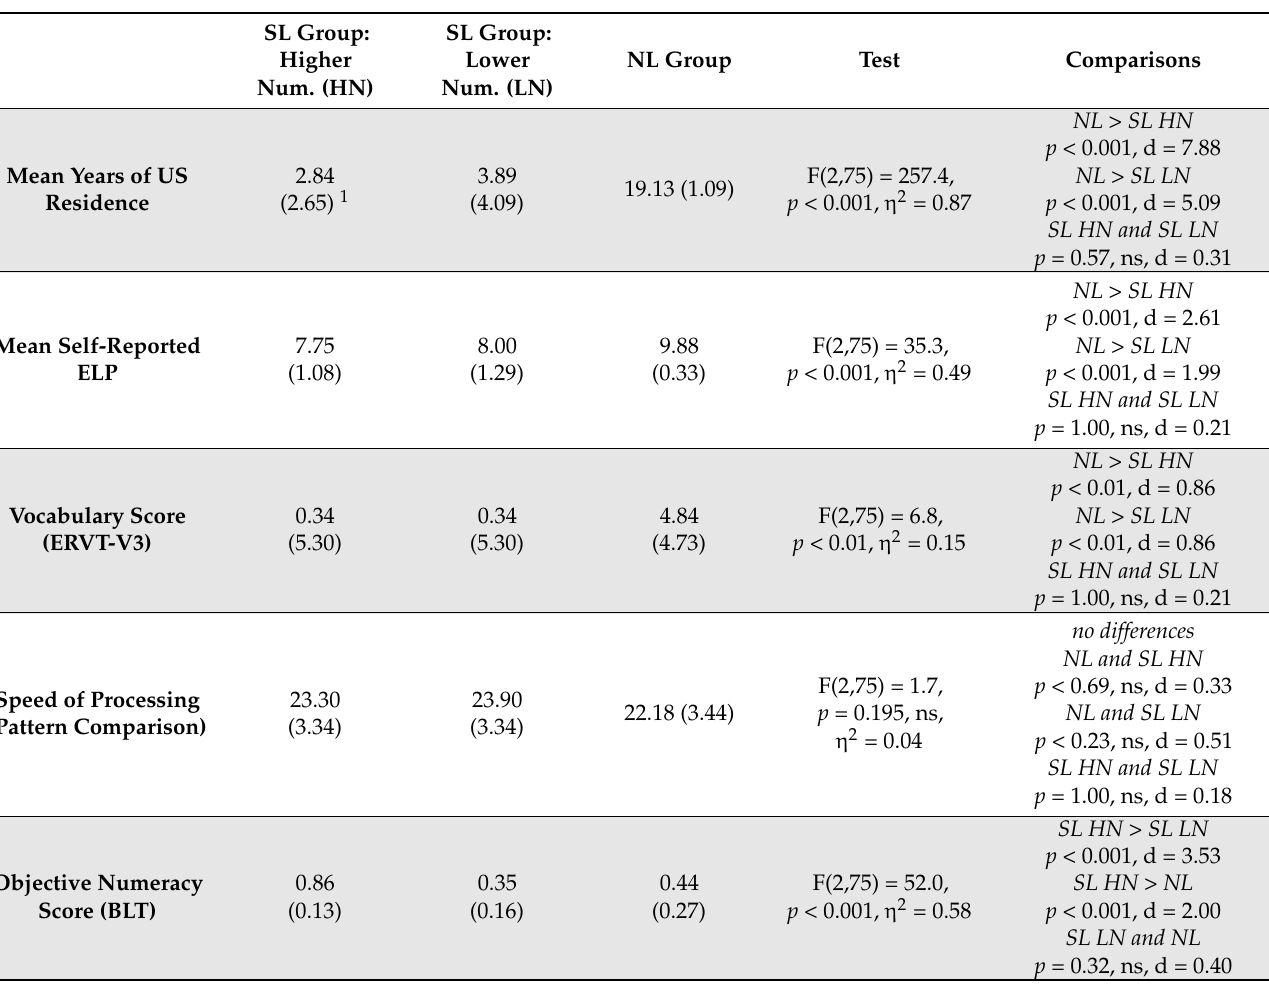
Table 1. Demographic information for the language